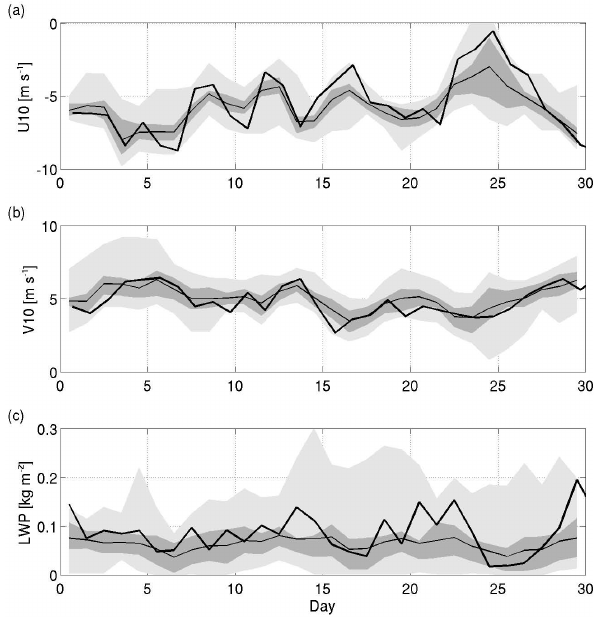
Fig. 13. Time series of 24-h averaged (a) 10-m zonal velocity (ms − 1 ), (b) 10-m meridional velocity (ms − 1 ), and (c) liquid wa- ter path (kgm − 2 ) for a 3 ◦ × 3 ◦ box centered at 20 ◦ S 85 ◦ W. Model means (light black line), 25th–75th percentile range (dark gray), and model range (light gray) are plotted. Heavy black lines indicate observations; QuikSCAT in (a) and (b) and AMSR-E LWP in (c), respectively. Day 0 on the time axis corresponds to 0 Z, 1 Octo- ber